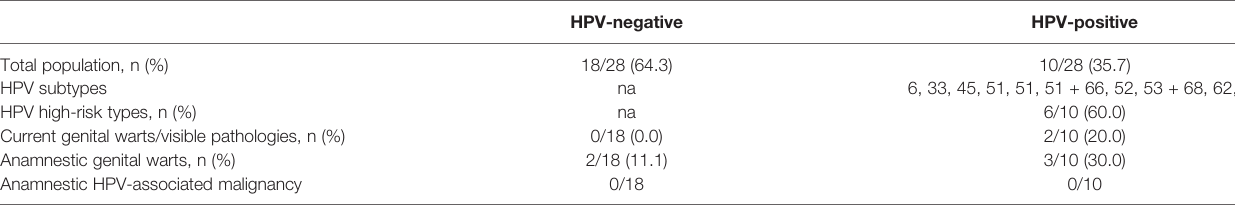
TABLE 2 | Prevalence and characteristics of genital